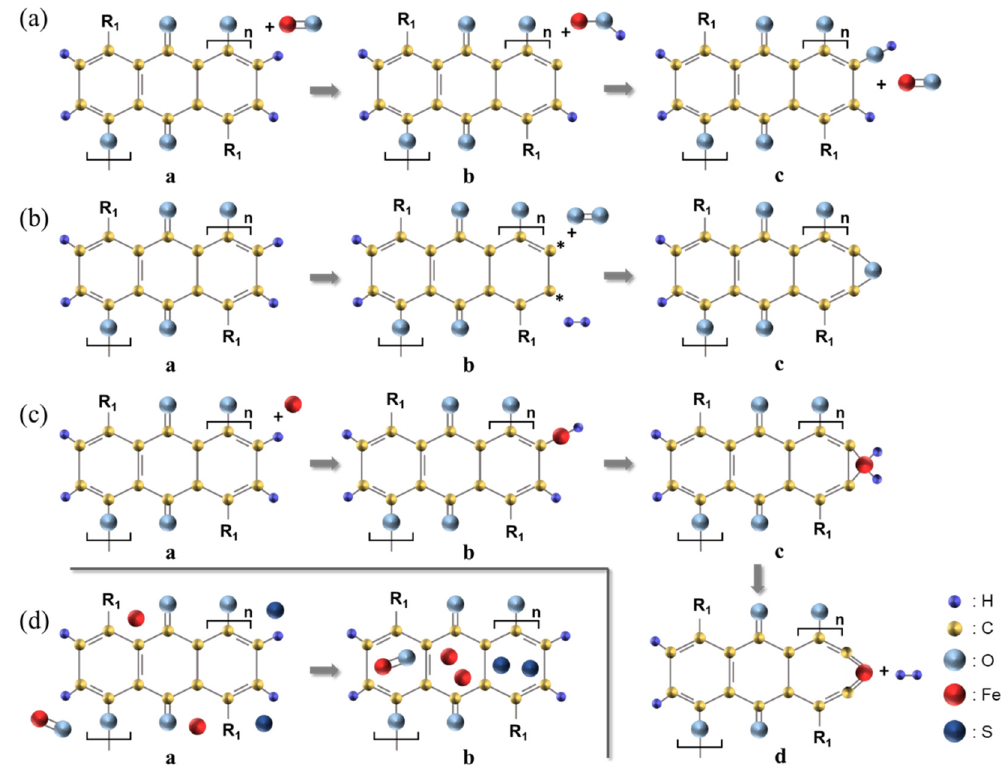
Figure 6. Transformation of the surface bonding states on the SOC film surface during CMP using the ferric catalyst (i.e., Fe 2 (SO 4 ) 3 ). The formation of ( a ) C-O-H, ( b ) C-O, ( c ) and C=Fe=C (C-C bond breakage), and ( d ) Fe=O, interstitial Fe, and interstitial S bond on the SOC film surface.